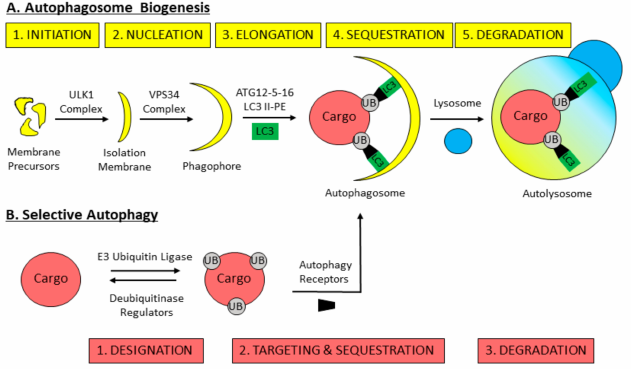
Figure 2. Schematic of mammalian selective autophagy. ( A ) Stages of autophagosome biogenesis and degradation. The ULK1 complex drives autophagy initiation to form the isolation membrane from membrane precursors. Nucleation of the isolation membrane by the VPS34 complex forms a cup-shaped membrane termed the phagophore. The phagophore elongates by the ubiquitin-like conjugation systems, ATG12-5-16 and LC3-II-phosphatidylethanolamine (PE), to form the autophagosome. The autophagosome sequesters cargoes within and undergoes fusion with a lysosome to form an autolysosome, where degradation occurs. ( B ) Selective autophagy cargoes are often marked for degradation by the addition of ubiquitin on their outer surface by E3 ubiquitin ligases. Ubiquitin designation signals can be dissipated from cargoes by deubiquitinases and regulators. Designated cargoes are targeted to the autophagosome through binding with autophagy receptors that interact with LC3-II on the autophagosome. Cargoes sequestered inside autophagosomes through binding with autophagy receptors are degraded in an